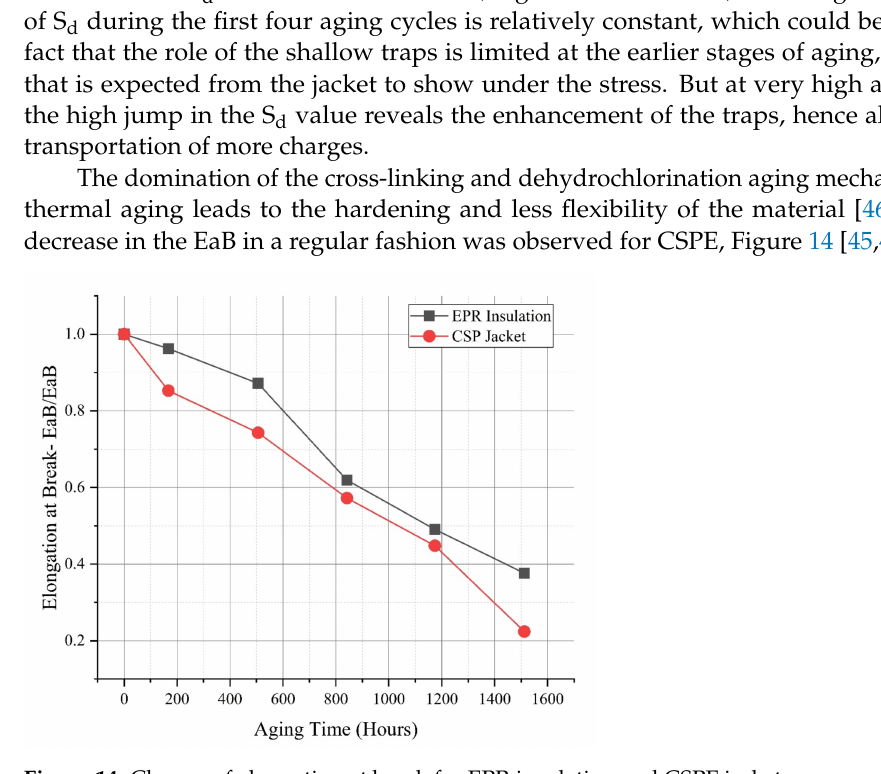
Figure 14. Change of elongation at break for EPR insulation and CSPE